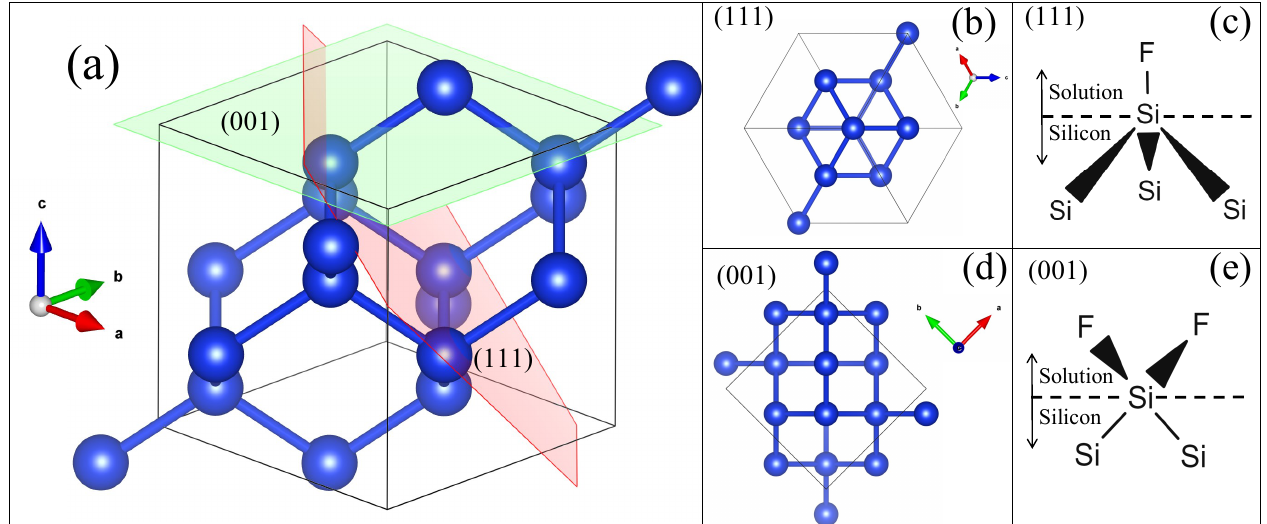
Figure 2. ( a ) Shows the crystalline unit cell of silicon and the (001) and (111) planes. Show crystalline cell since ( b ) (111) and ( d ) (001) planes. ( c , e ) are a molecular schematic of interface solution/Si for (111) and (001) planes